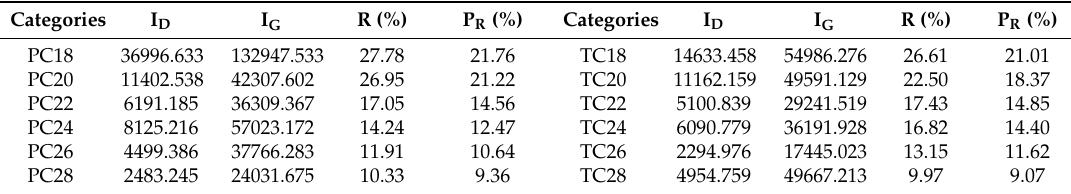
Figure 6. The relationship between the degree of disorder results of three methods and the heat treatment temperature graph. ( a ) The relationship between disordering degree of petroleum coke and heat treatment temperature; ( b ) The relationship between disordering degree of pitch coke and heat treatment temperature.